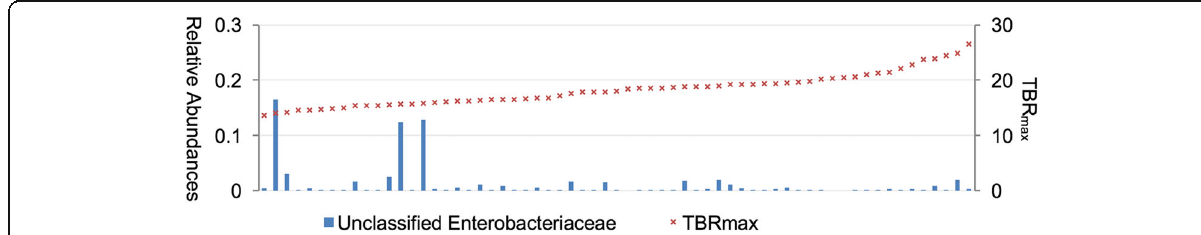
Fig. 5 The association between the unclassified Enterobacteriaceae and TBR